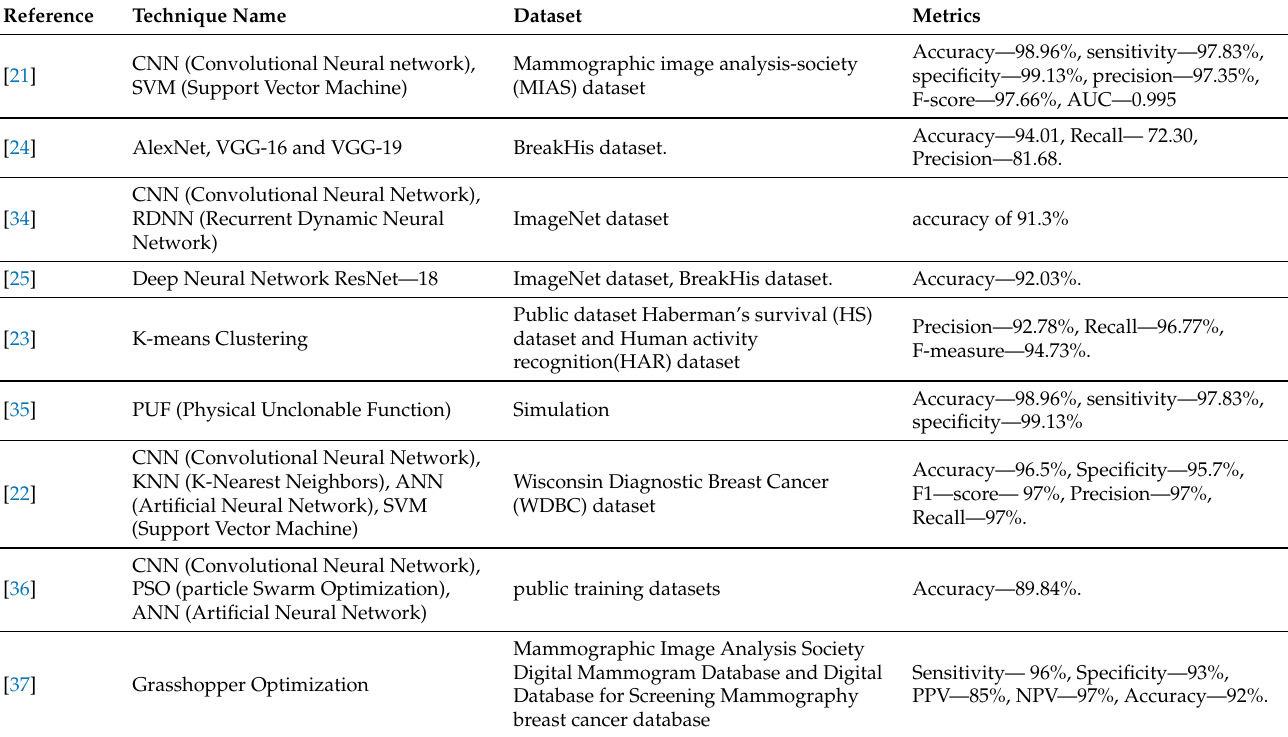
Table 1. Parameters utilized for the